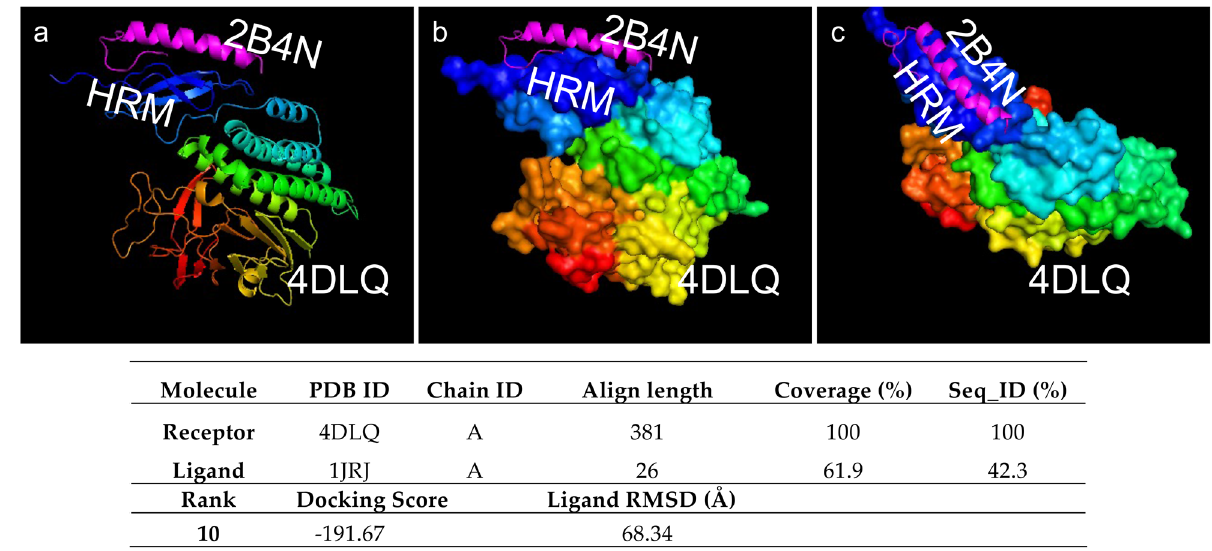
Figure 4. Results of protein–protein docking conducted in HDOCK. Note the three views of 4DLQ (HRM domain) and 2B4N (GIP) in navy blue and magenta, respectively. ( a ) β-helixes and α-helixes complex. ( b )